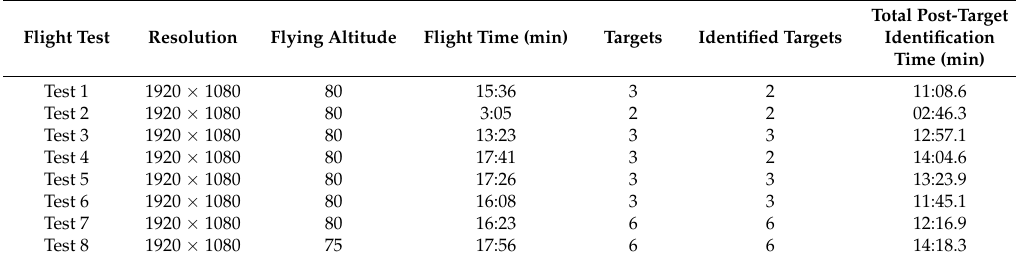
Table 2. Post-target identification results.